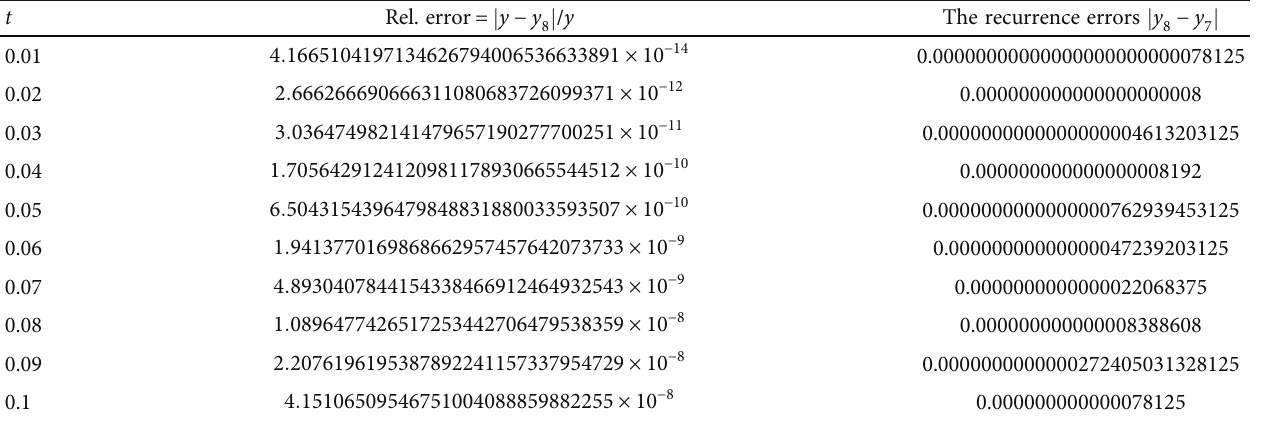
Table 11: Relative error = j y − y Example